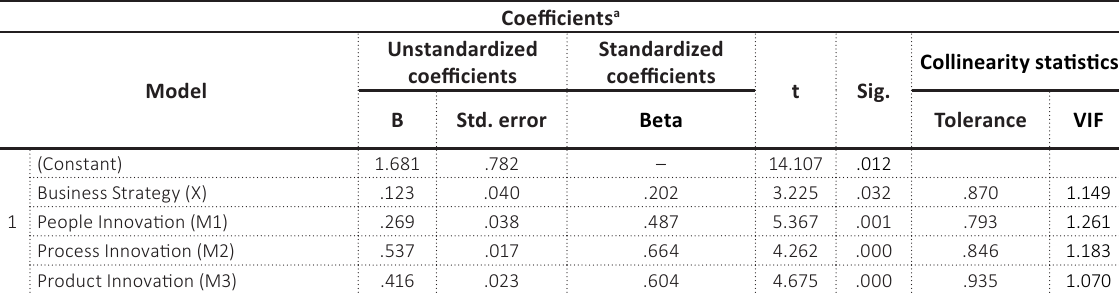
Table 7. Multicollinearity test for the 2 nd regression